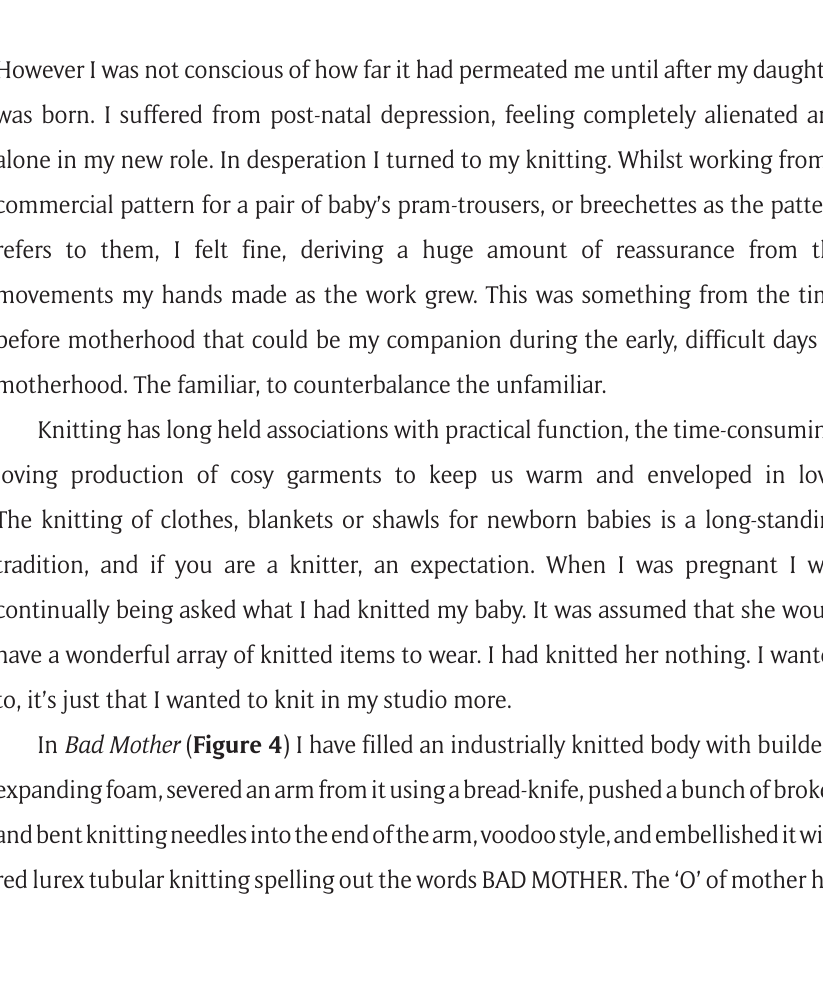
Figure 3: DO I FIT IN , 2005, hand knitted wool, 800 × 340 mm. Knitted for me by Freda Burgher. In Private Collection. Photograph: Douglas